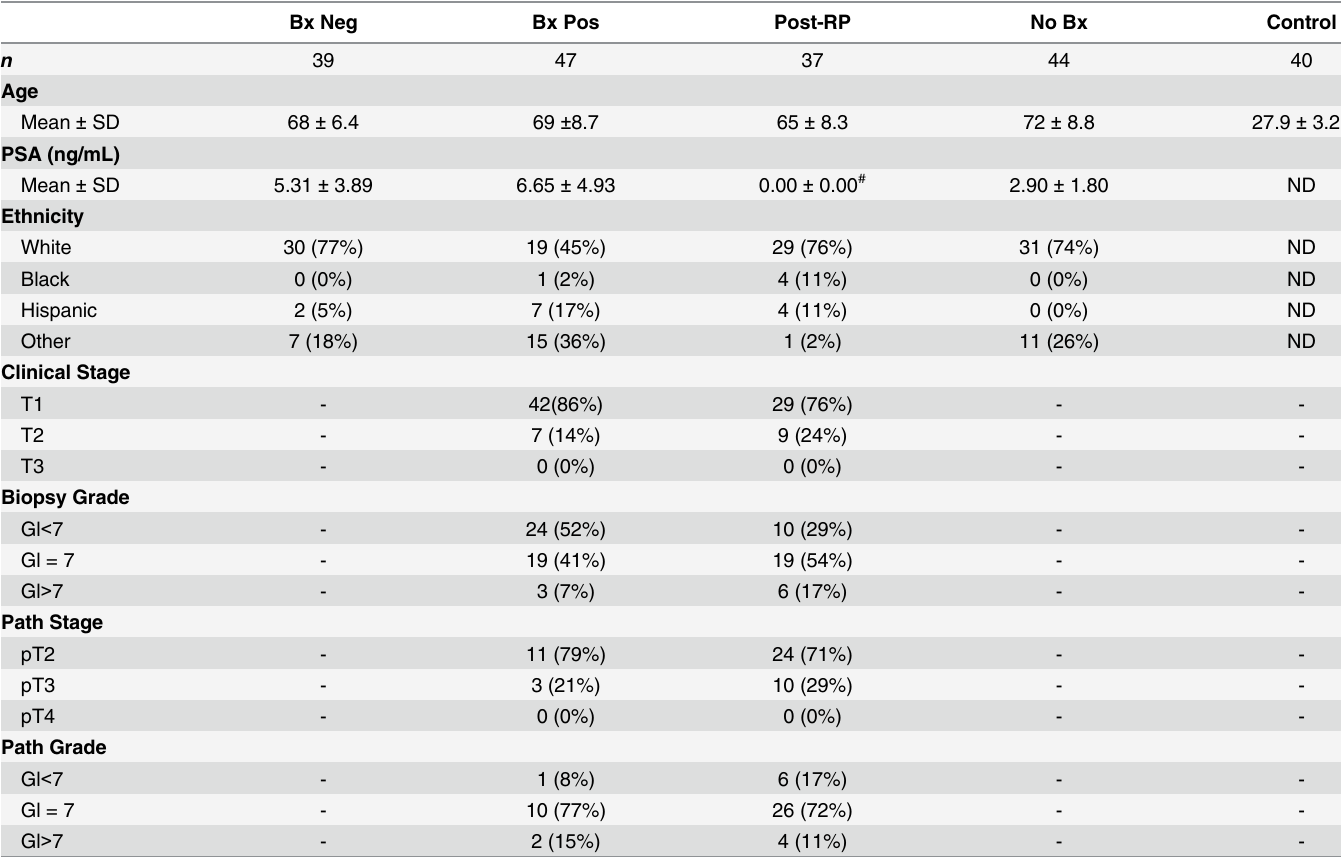
Table 3. Patient